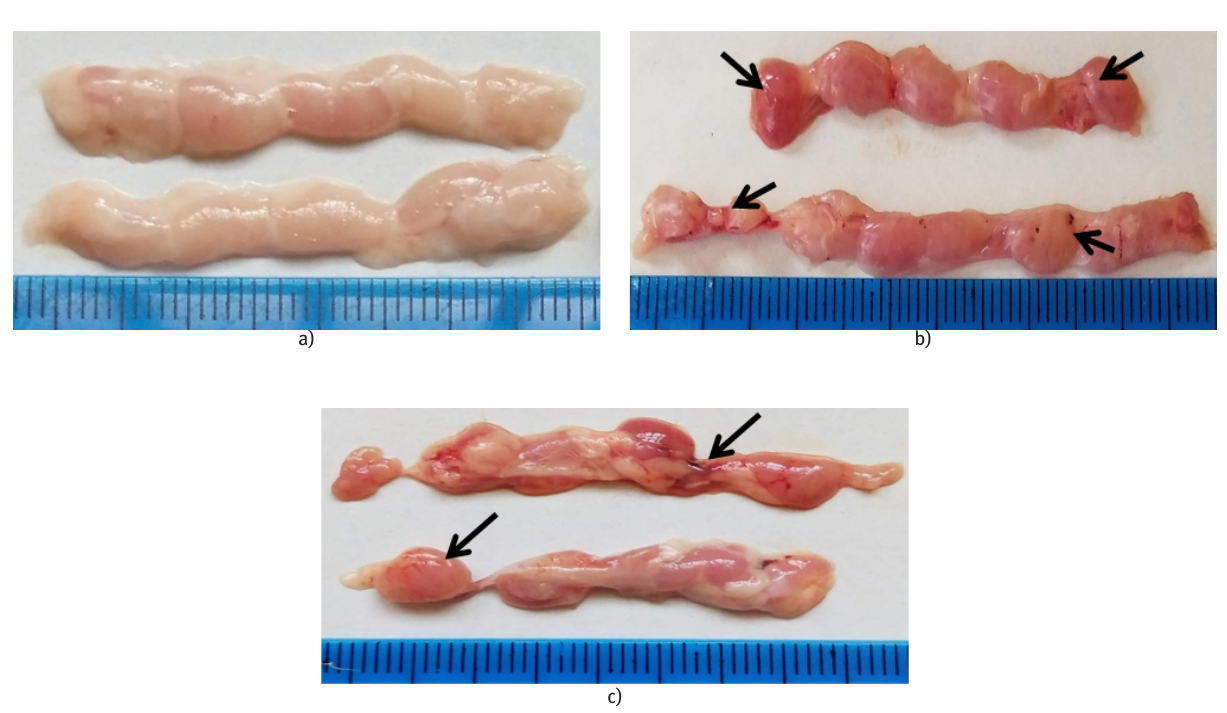
Figure 1: Photograph of thymus of chickens post-inoculation and/or exposure to a very virulent infectious bursal disease virus. Note intact thymic lobes in group A (a), congested, haemorrhagic thymic lobes (arrows) in group B (b) and C (c) chickens.